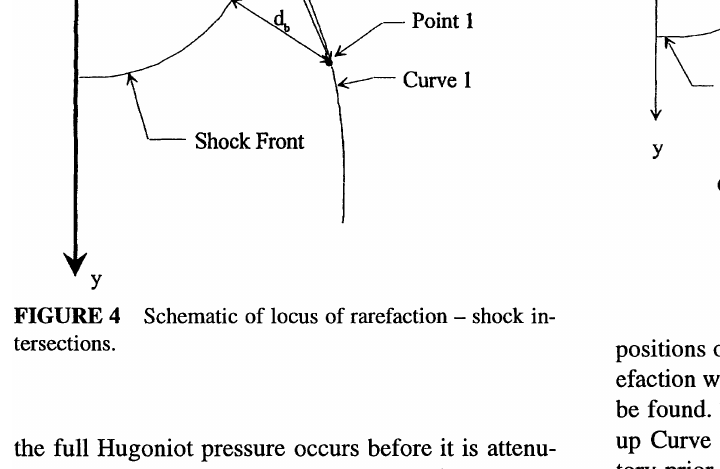
FIGURE 5 Schematic of Curve